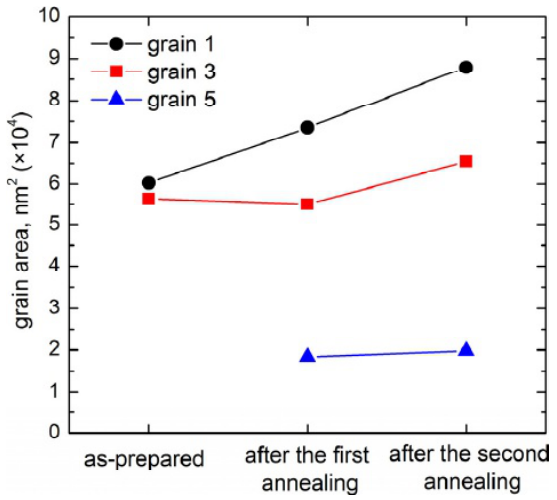
Fig. 4. The area of the grains 1, 3, and 5 in as- prepared state, after the first and the second an-